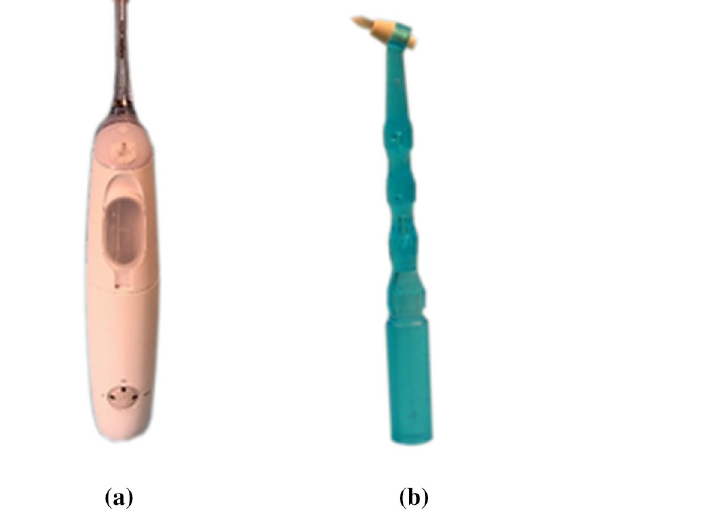
Figure 1. The Sonicare AirFloss Ultra HX8431 ( a ) and the sulcus brush I-Prox P ( b ) were used for cleaning.